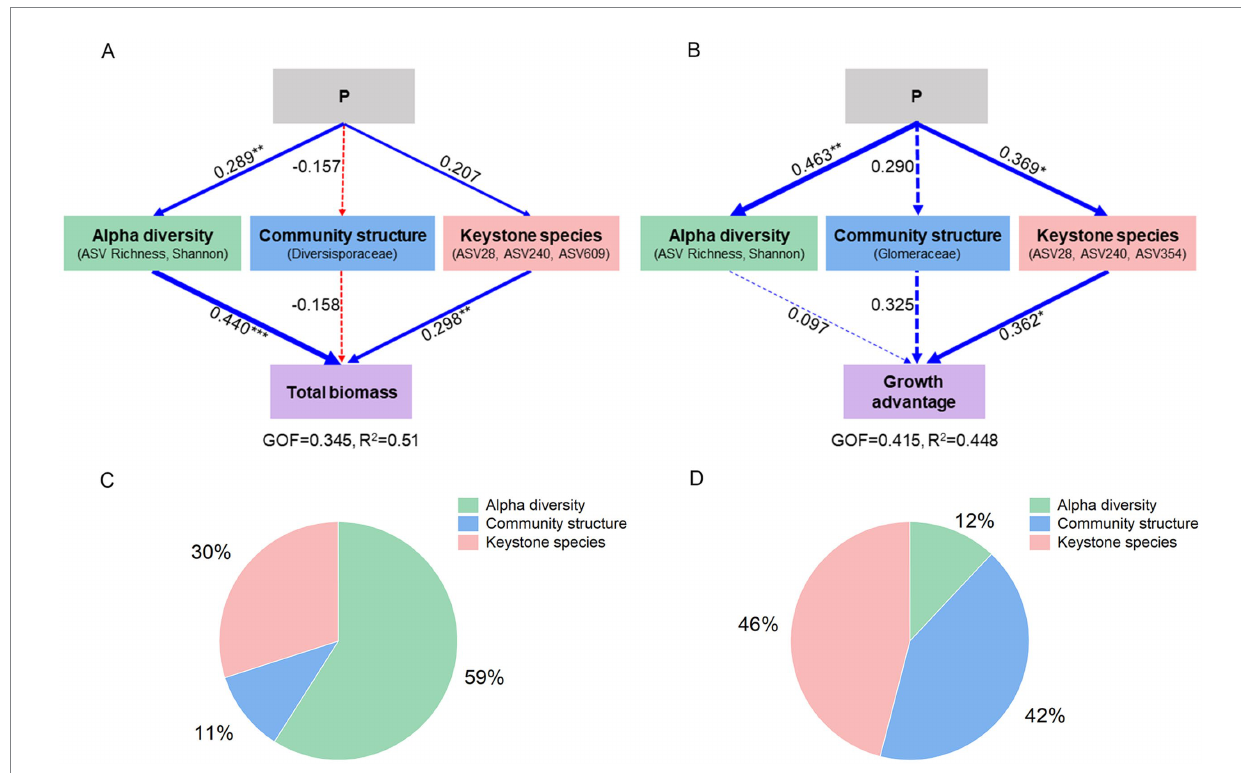
FIGURE 6 Path models showing the effects of P treatments on (A) plant growth and (B) growth advantage of S. canadensis over S. decurrens through alpha diversity, community structure and keystone species of the AMF. The line size represents the value of the path coefficient. The solid and dash lines represent significant and non-significant relationship. Blue lines represent positive effects, red lines represent negative effects. The asterisks denote the significance of path coefficient. * p < 0.05, ** p < 0.01, *** p < 0.001. The final models fit the data well, as assessed using GOF and R 2 . The relative contribution of AMF latent variables to global explained observed variability ( R 2 ) of the (C) total biomass of two Solidago species and (D) growth advantage of S. canadensis over S.